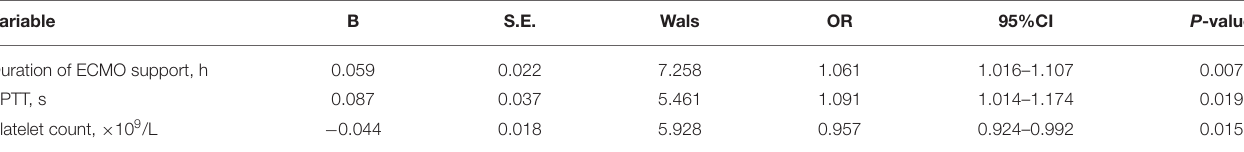
TABLE 4 | Logistic regression analysis for the related factors predicting